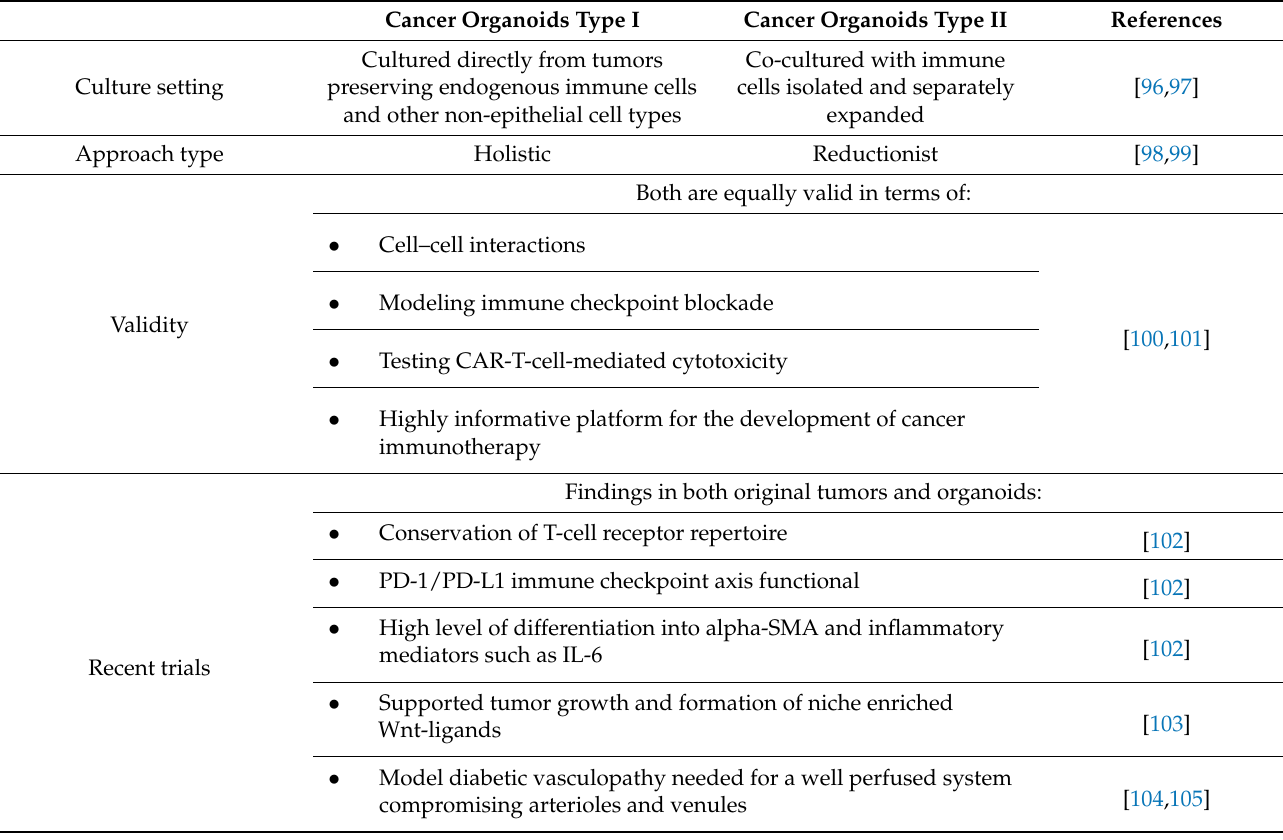
Table 2. Newly advanced microenvironment-based organoid models.